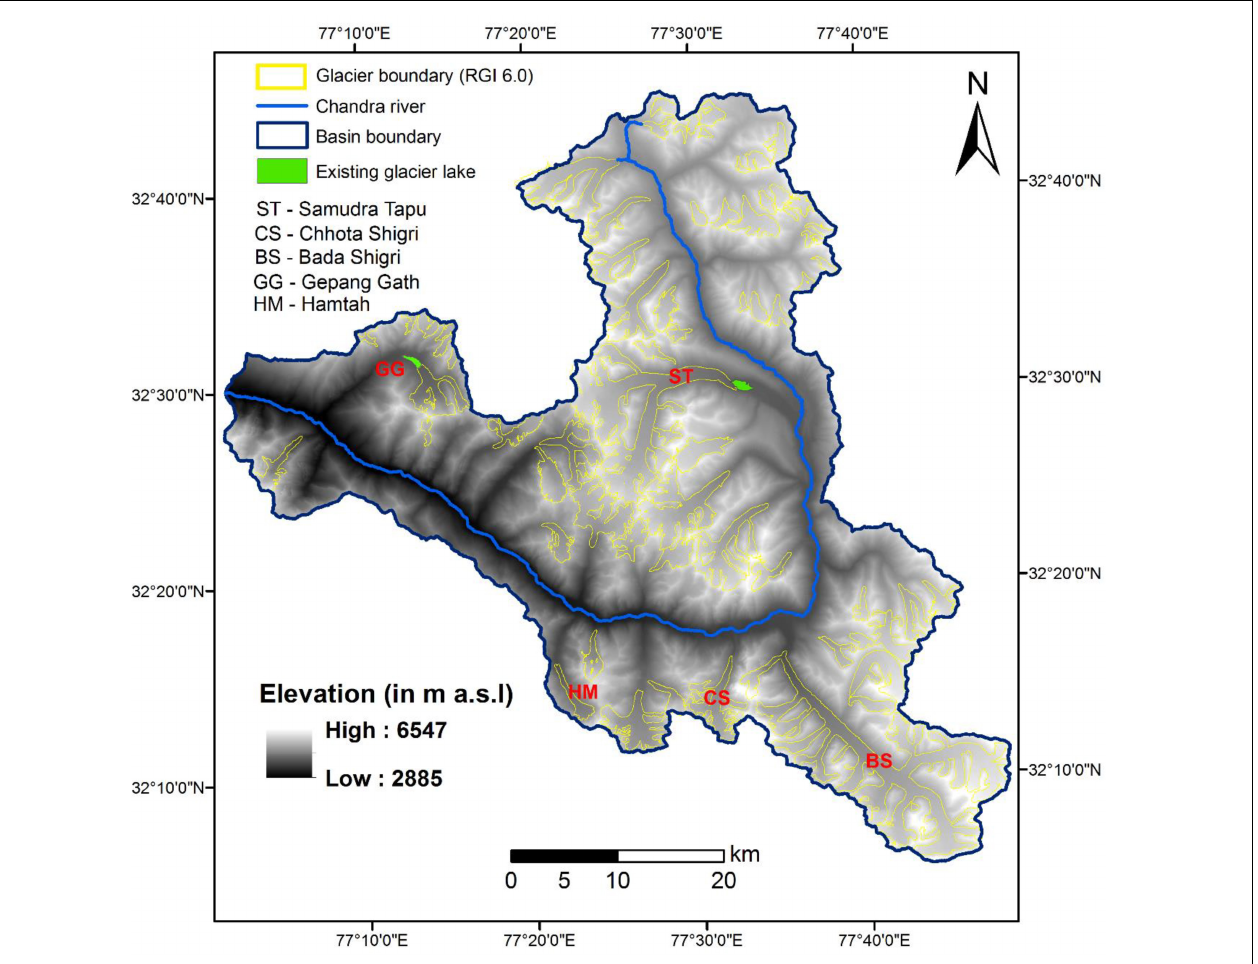
FIGURE 1 | Map of the study area showing locations of the 65 study glaciers in Chandra river basin, Lahaul-Spiti valley, Himachal Pradesh, India. The background image is TDX DEM (10 m resolution) generated using SAR interferometry